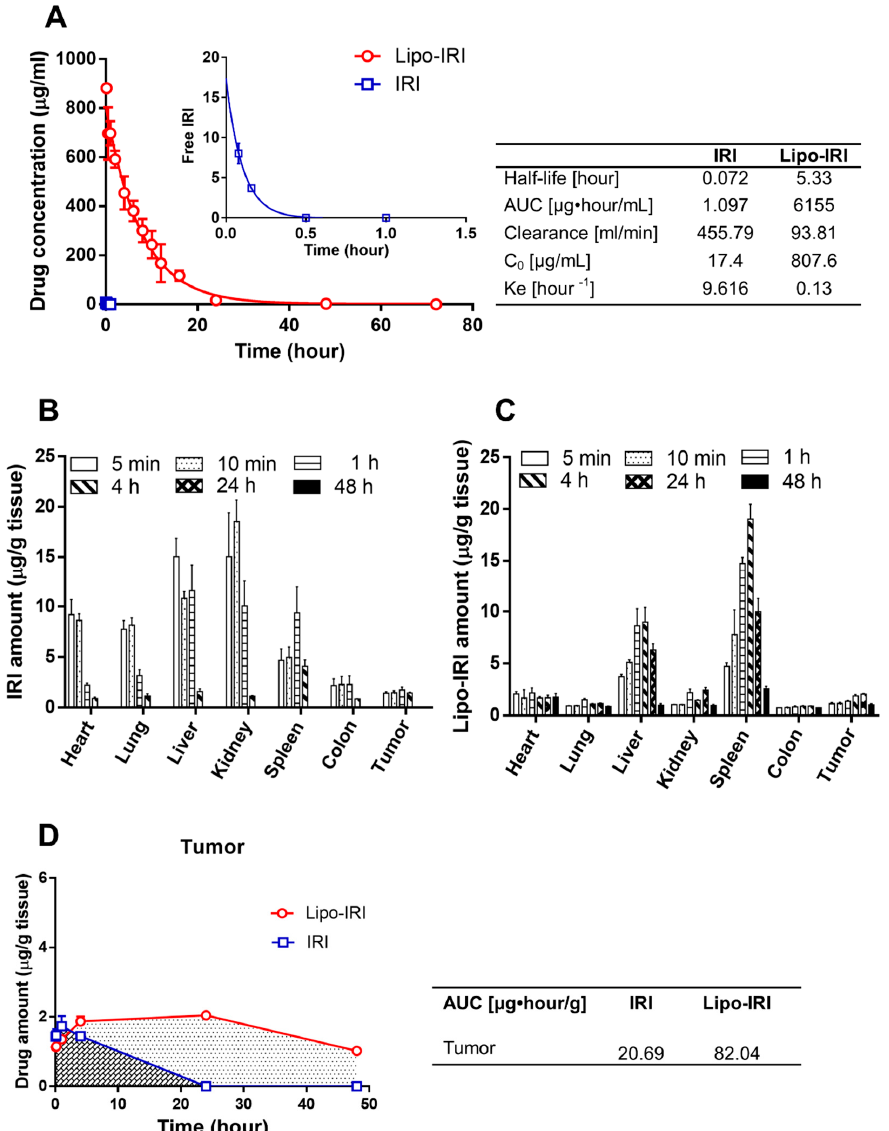
Figure 3. Pharmacokinetic and bio-distribution profile of Lipo-IRI and free IRI in tumor-bearing mice. Following an injection with IRI or Lipo-IRI, the blood and organs were collected at various time-points. The pharmacokinetics are shown in ( A ). The inset shows the profiles in the first hour after administration. The data are shown for Lipo-IRI ( ○ ) and free IRI ( □ ). The organs were homogenized, and the amount of IRI was quantified by RP-HPLC. The bio-distribution profiles of IRI and Lipo-IRI are shown in ( B ) and ( C ). The AUC for Lipo-IRI and IRI is shown in ( D ). The data are represented as the mean ± SD ( n = 3).